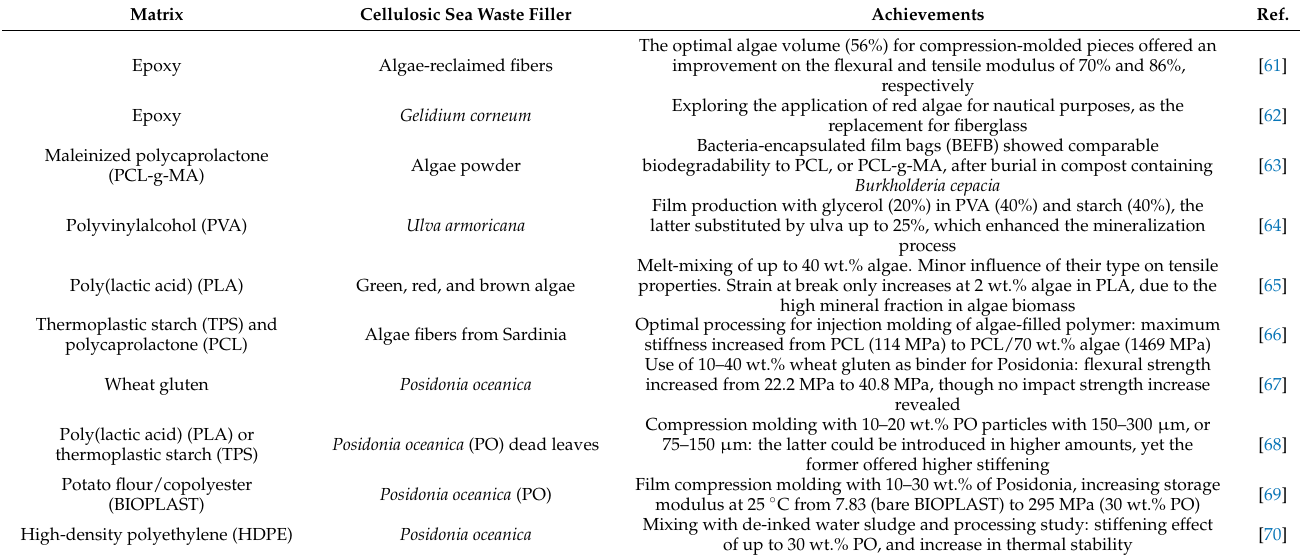
Table 2. Studies on prevalently cellulosic sea waste in polymer